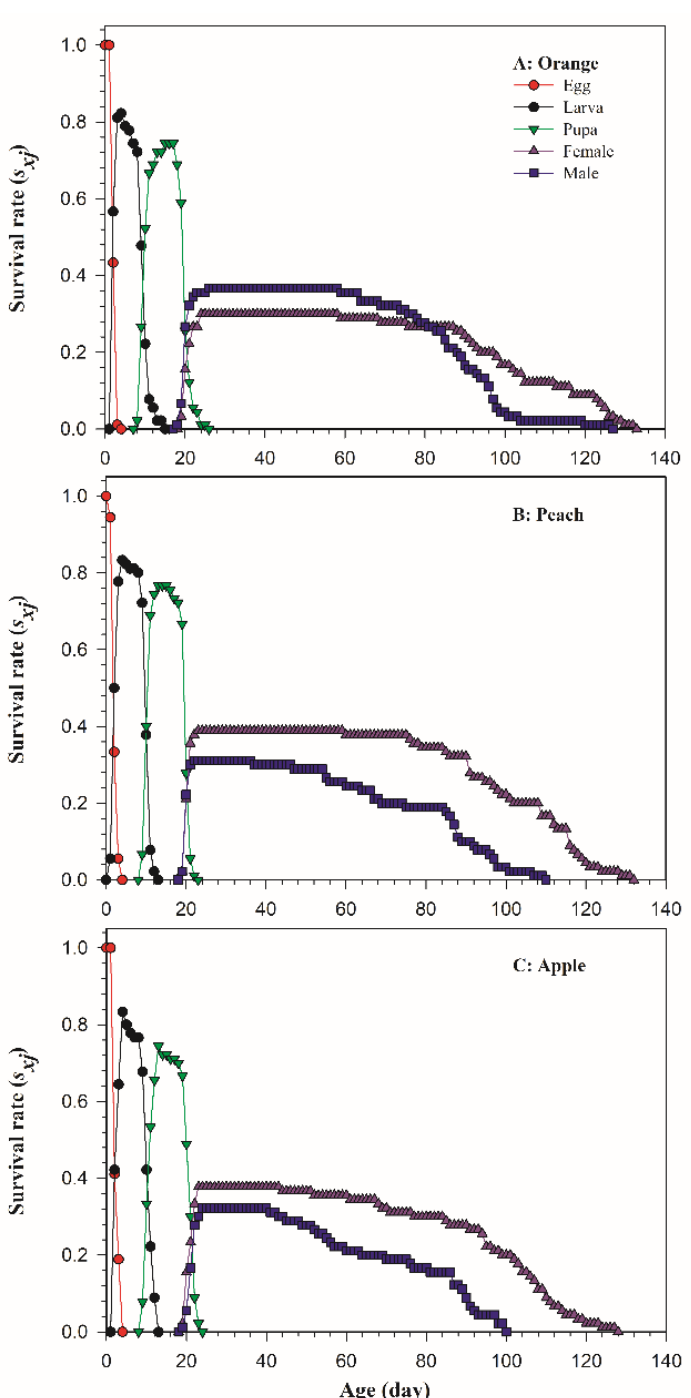
Figure 1. The age-stage specific survival rates ( s xj ) of Bactrocera dorsalis on three host fruits: ( A ) orange; ( B ) peach; ( C ) apple.